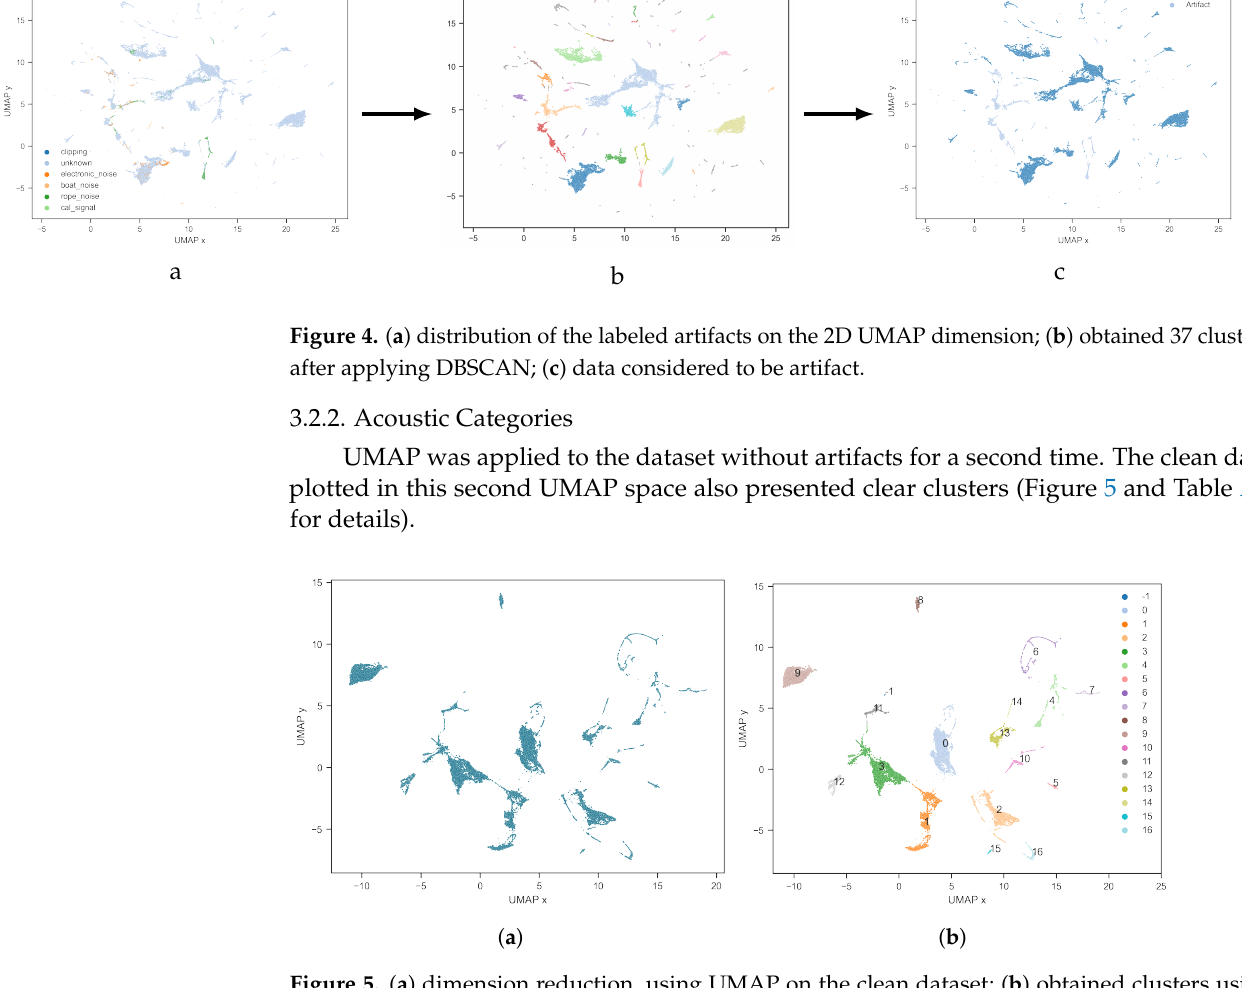
Figure 5. ( a ) dimension reduction, using UMAP on the clean dataset; ( b ) obtained clusters using UMAP projection: − 1 represents the noise